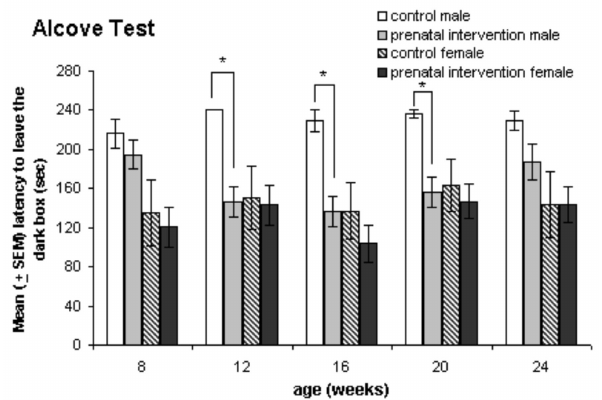
Figure 2 - Alcove test. The time (in seconds) spent in a dark box before exploring a brightly lit open field was measured at weeks 8, 12, 16, 20 and 24 for the male (n = 6) and female (n = 6) controls and male (n = 16) and female (n = 14) prenatal intervention groups. The two latencies, A1 and A2, were summed. The male prenatal intervention group and the females exited the dark box more quickly than the male controls over the test period of 24 weeks. The values of males differed at weeks 12, 16 and 20; male and female controls displayed differences at weeks 16, 20 and 24; *p ≤ 0.01.